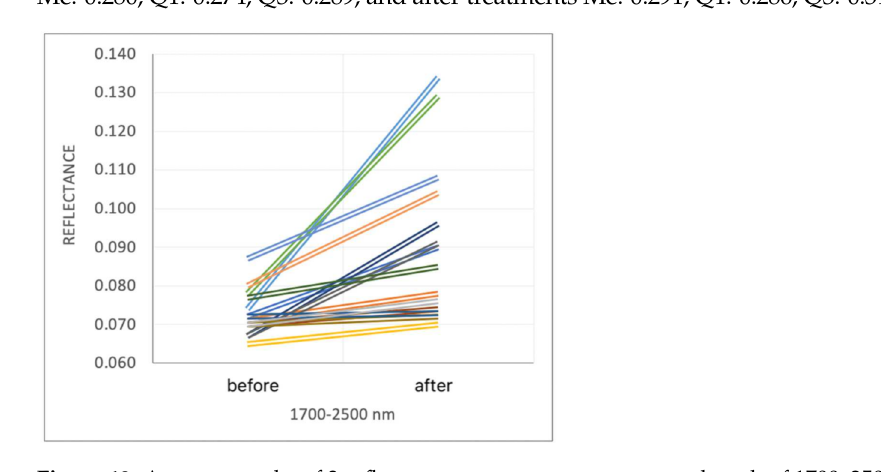
Figure 13. Average results of 3 reflectance measurements at a wavelength of 1700–2500 nm in every woman undergoing microdermabrasion, before and after the